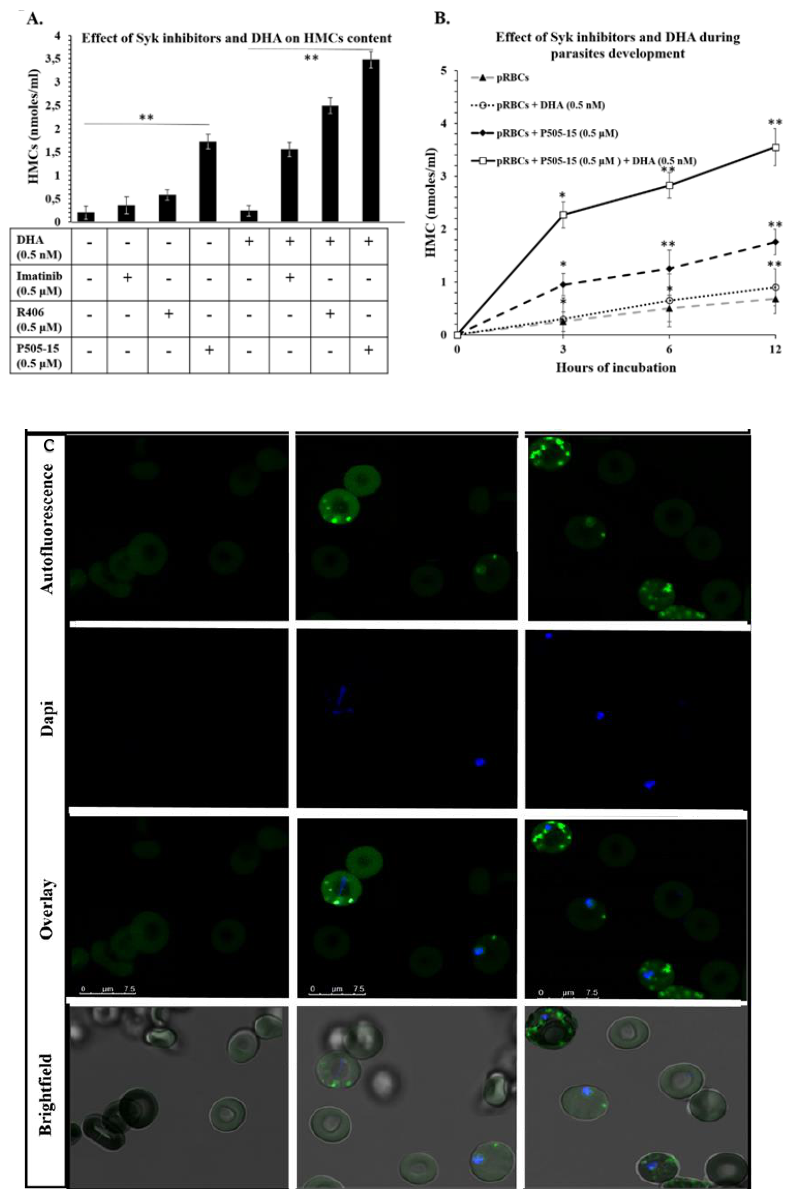
Figure 1. ( A ) Effect of parasitized red blood cell (pRBC) treatments with Syk inhibitors (imatinib, R406, and P505-15) (0.5 µM) and dihydroartemisinin (DHA) (0.5 nM) on the accumulation of HMC after 12 h of incubation. ( B ) Time course of hemichrome (HMC) accumulation contained in pRBCs treated with the representative Syk inhibitor, P505-15 (0.5 µM) and/or DHA (0.5 nM) for 3, 6, and 12 h. Data are the average of five independent experiments ± SD. Significant differences to untreated pRBCs at * p < 0.05; ** p < 0.001. ( C ) Confocal Images of HMCs contained in pRBCs untreated and treated for 12 h with P505-15 (0.5 µM). HMCs were visualized by their autofluorescence at 488 nm (excitation) / 630–750 nm (emission). Images were acquired using the same magnification with a Leica TCS SP5 X (Leica Microsystems, Germany) confocal microscope equipped with a 60 × 1.4 numerical aperture oil immersion lens. The scale bar in the figure is 7.5 µ